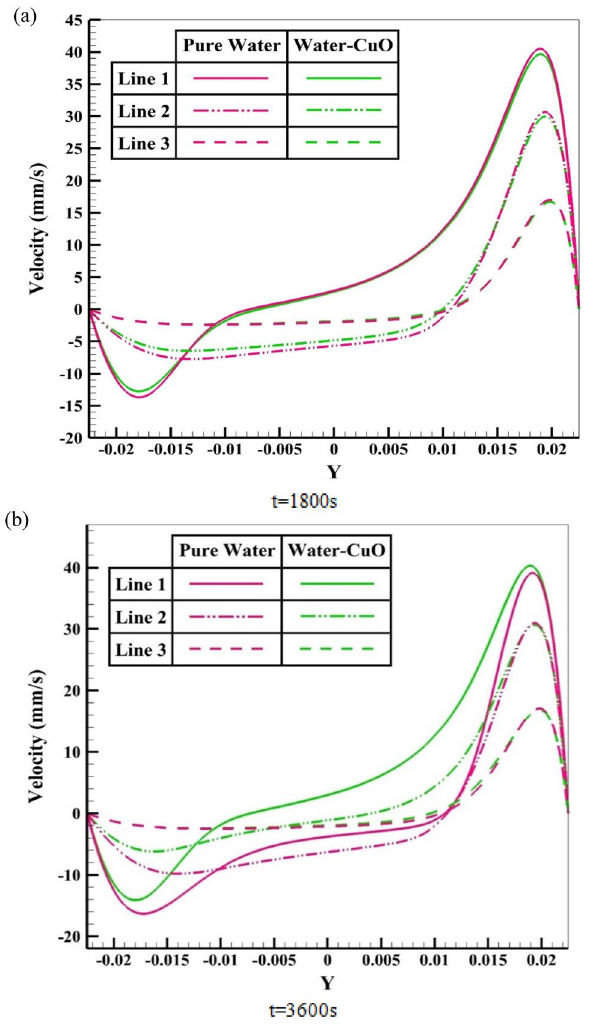
Figure 7. Distribution of velocity at various